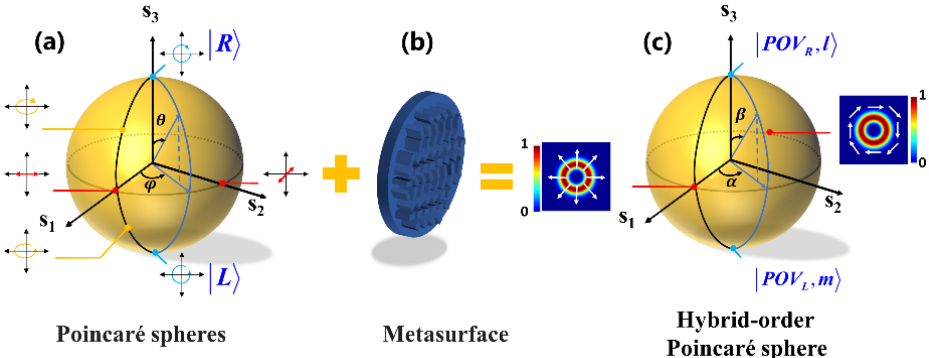
Figure 5. Illustration of generating PPBs through a dielectric metasurface with the aid of PS and HyOPS. ( a ) Schematic of Poincaré sphere. A point on the Poincaré sphere represents the polarization state of the incident light. ( b ) Schematic of the spin-decoupled metasurface that can superpose two completely different PVBs. ( c ) The output PPBs is represented by points on the HyOPS. The inset illustrates the radially and azimuthally polarized beams’ intensity and polarization distribution (depicted by white arrows) on the HyOPS with l = − 1 and m = 1.